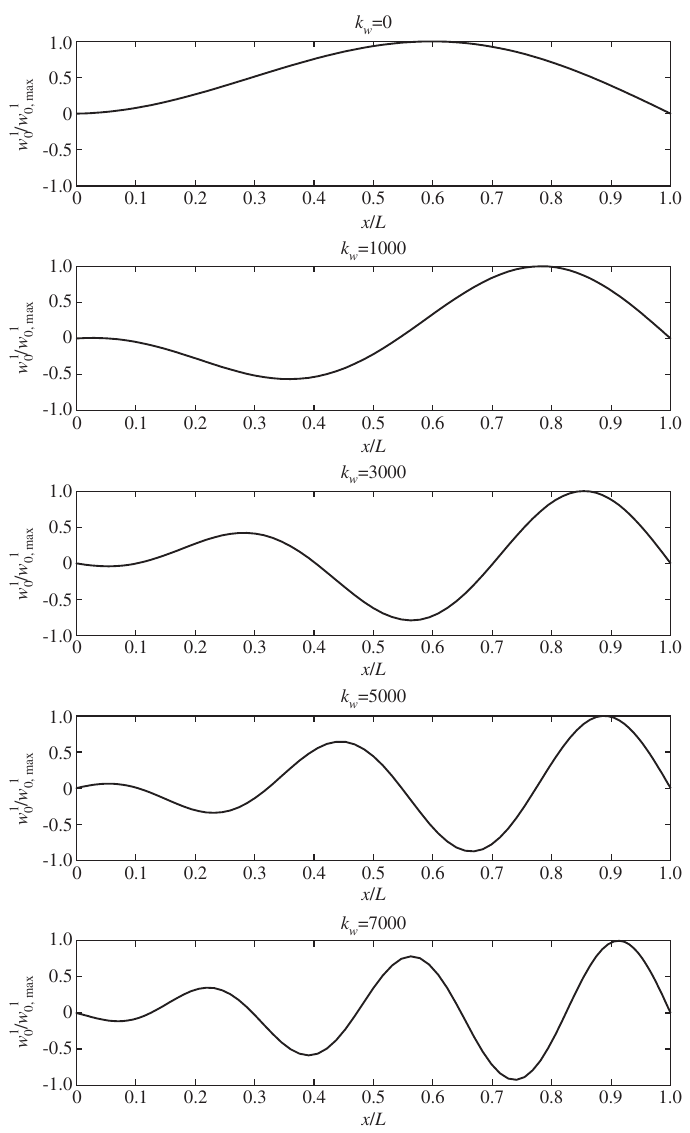
Figure 7 Buckled configurations of C-S composite laminated beams with L / h = 20 and [0/90/0] lay-up resting of Winkler